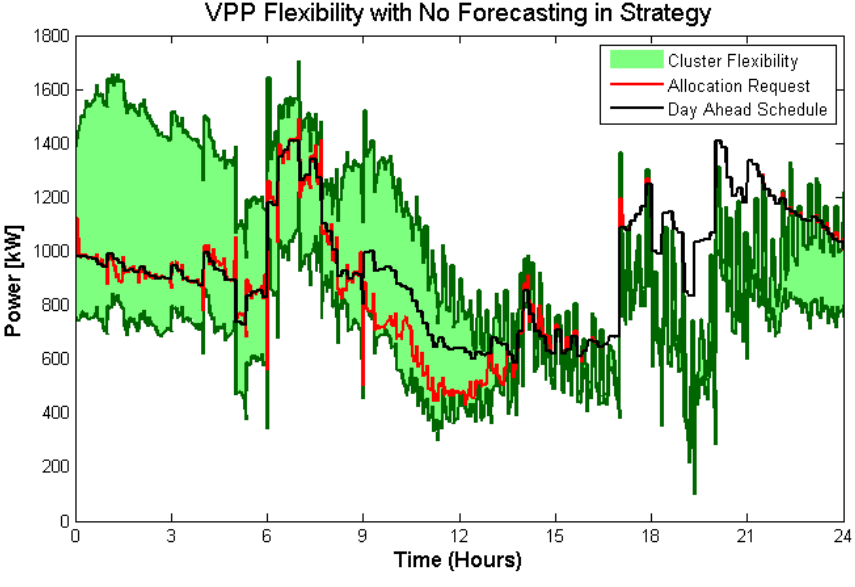
Figure 11. Flexibility degradation with no